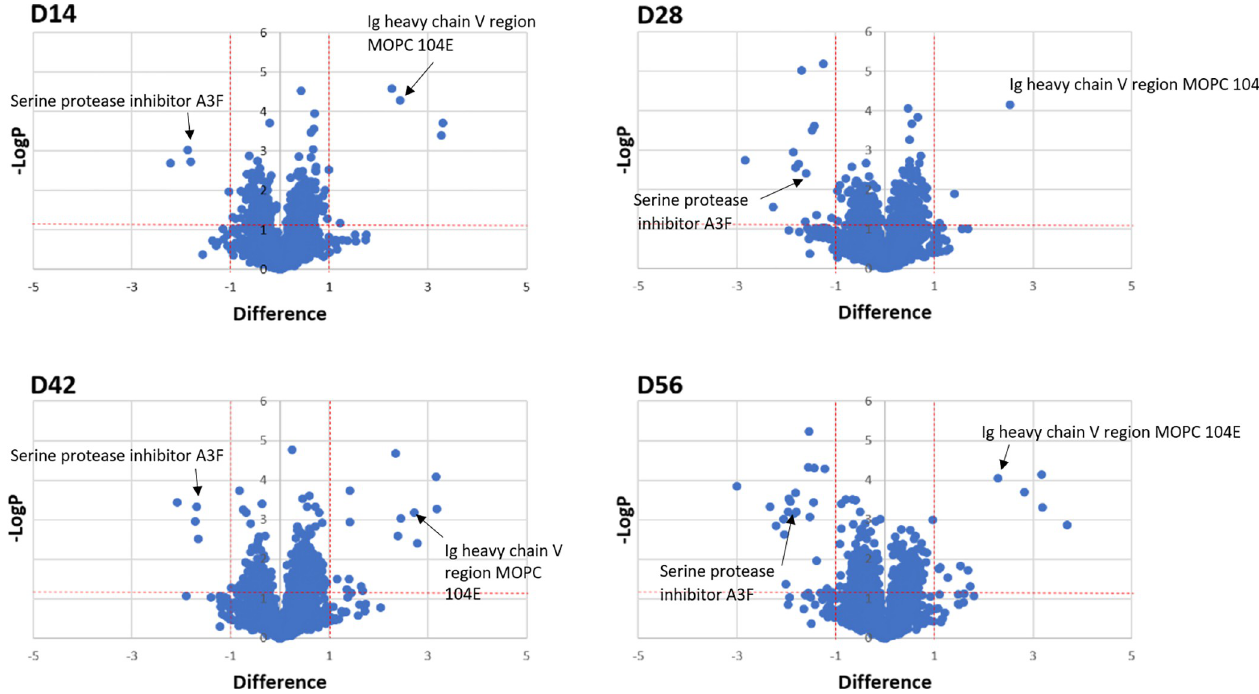
Fig 2. Comparison of protein expression in uninfected and infected mouse sera at 14- (D14), 28- (D28), 42- (D42), and 56- (D56) days post-infection with S . mekongi using volcano plots. Two vertical red lines represent differences as a minimum 2-fold changes relative to pre-infection conditions. The horizontal red line represents statistically significant at p-value < 0.05. Dots above the horizontal red line with the difference more than 1 and less than -1 indicate up-regulated and down-regulated mouse serum proteins, respectively. Arrows indicate differential proteins found in all four post-infection time points.